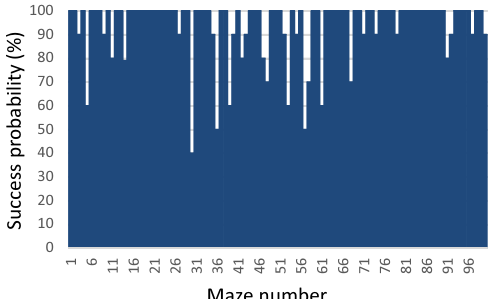
Figure 12: Proposed method(Q-learning) case 3 Figure 13: Proposed method(Pro(cid:28)t Sharing) case 3